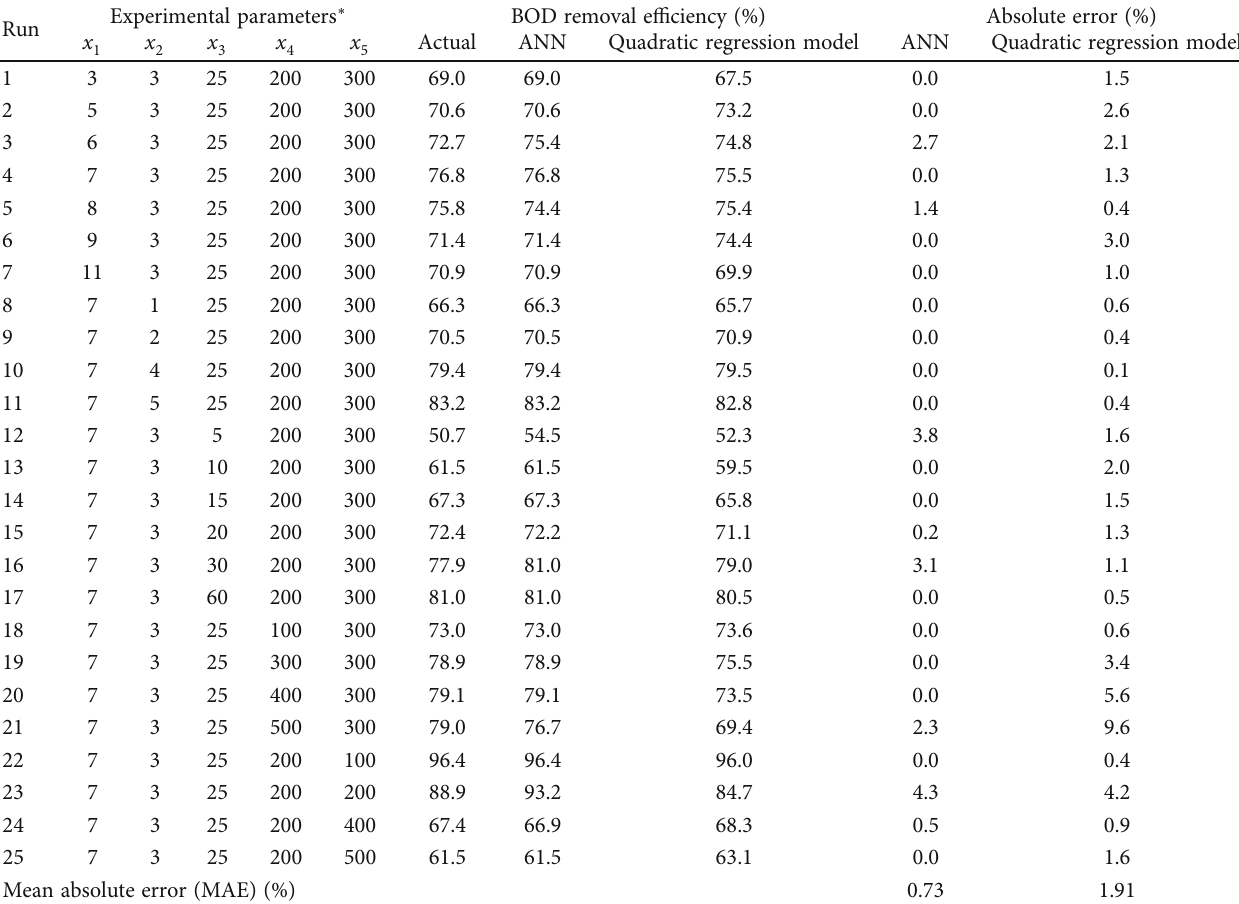
Table 6: Veri fi cation of quadratic regression and ANN models for predicting BOD removal using additional experimental runs. Experimental parameters Run